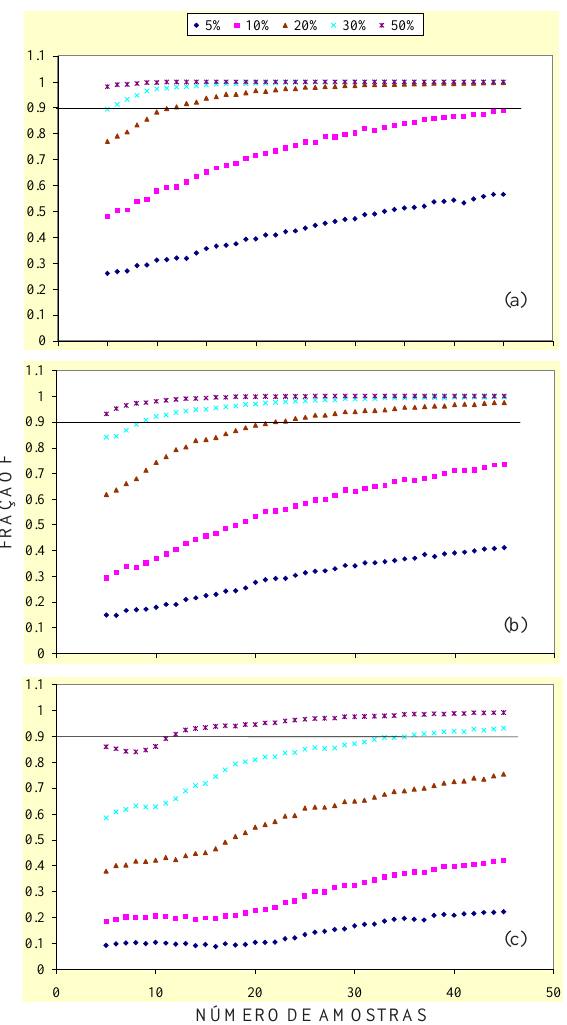
Figura 3. Fração da amostra “bootstrap” para bbbbb , considerando 5, 10, 20, 30 e 50 % de variação em torno da média e do tamanho da amostra, nas profundidades de 0,30 (a), 0,45 (b) e 0,60 m